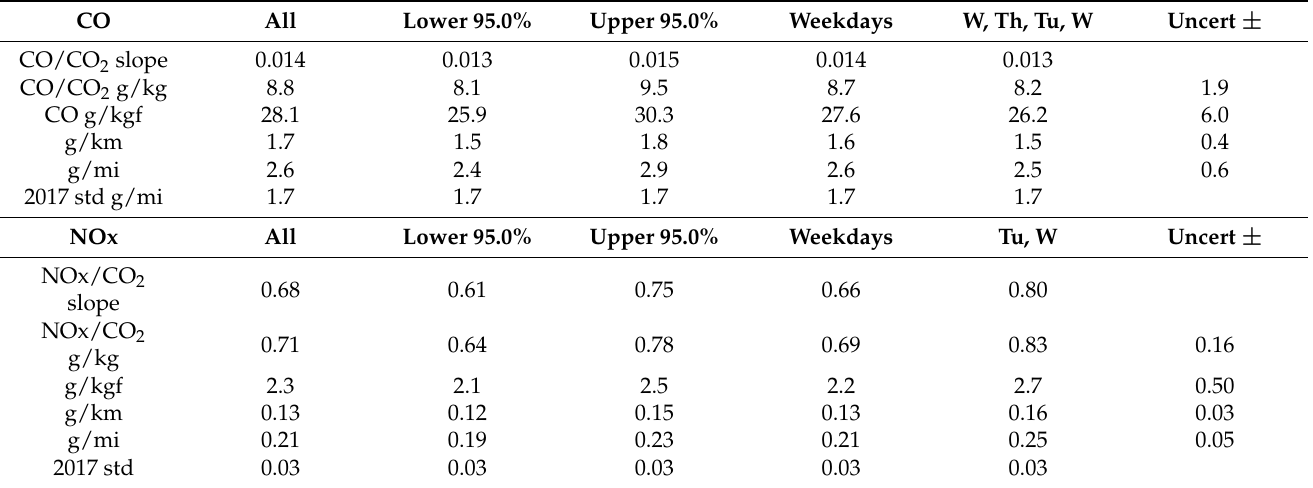
Table 4. Fuel specific emissions for CO, NOx and NO and regulated emissions for CO and NOx. Range of estimates and confidence limits shown.